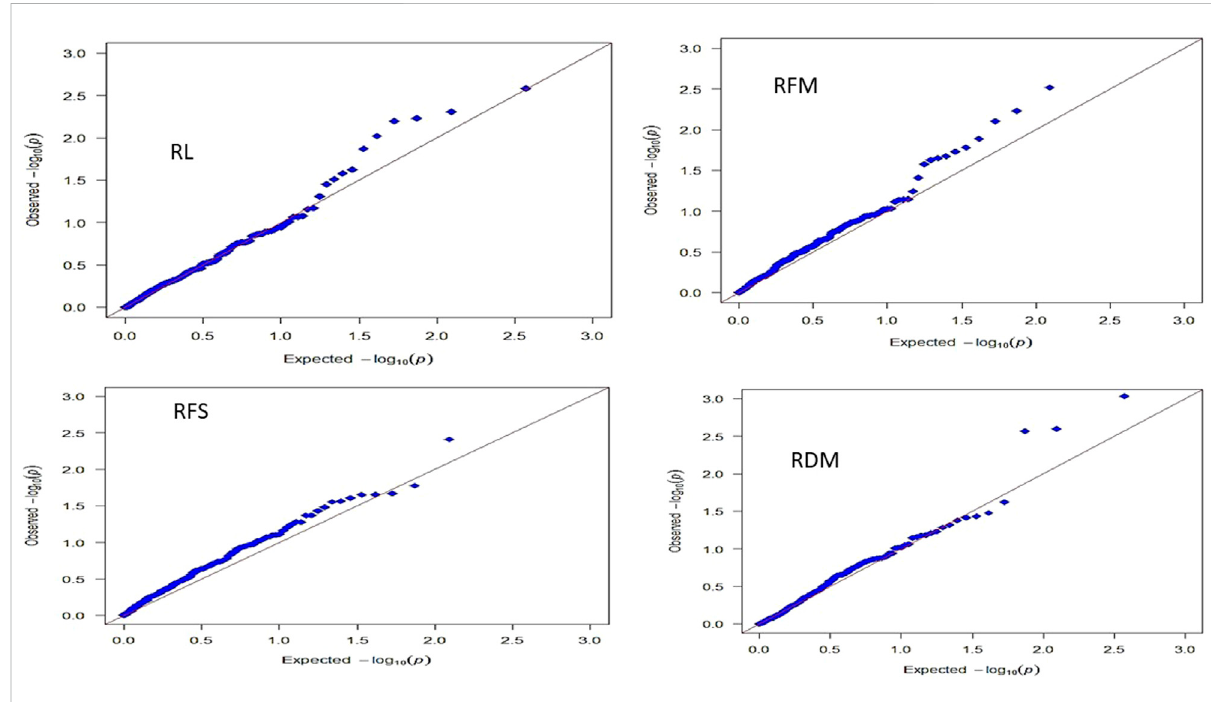
FIGURE 4 QQ plots resulted from the GWAS using the GLM model for each